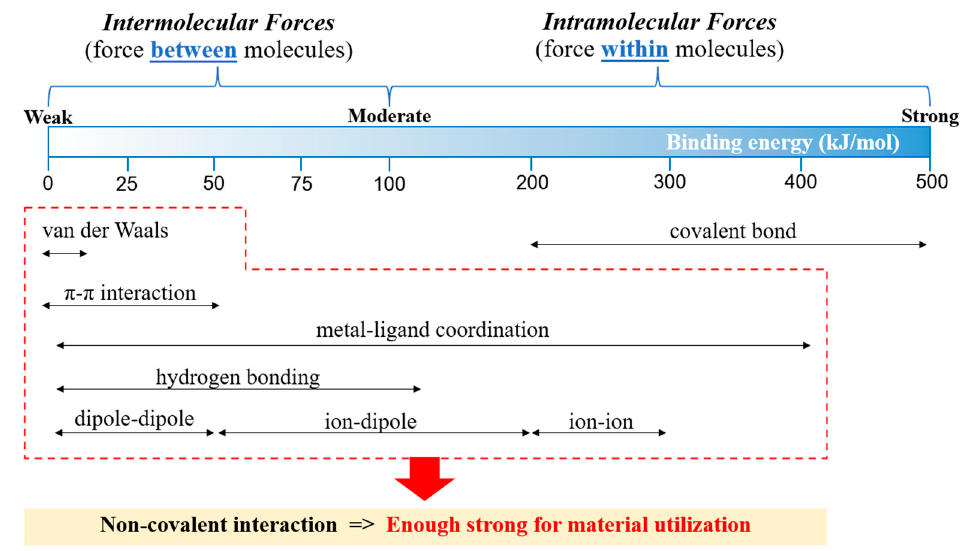
Figure 1. Types of molecular interaction and their binding strength [16]. Adapted from [16], Copy- right 2017, with permission from Elsevier.